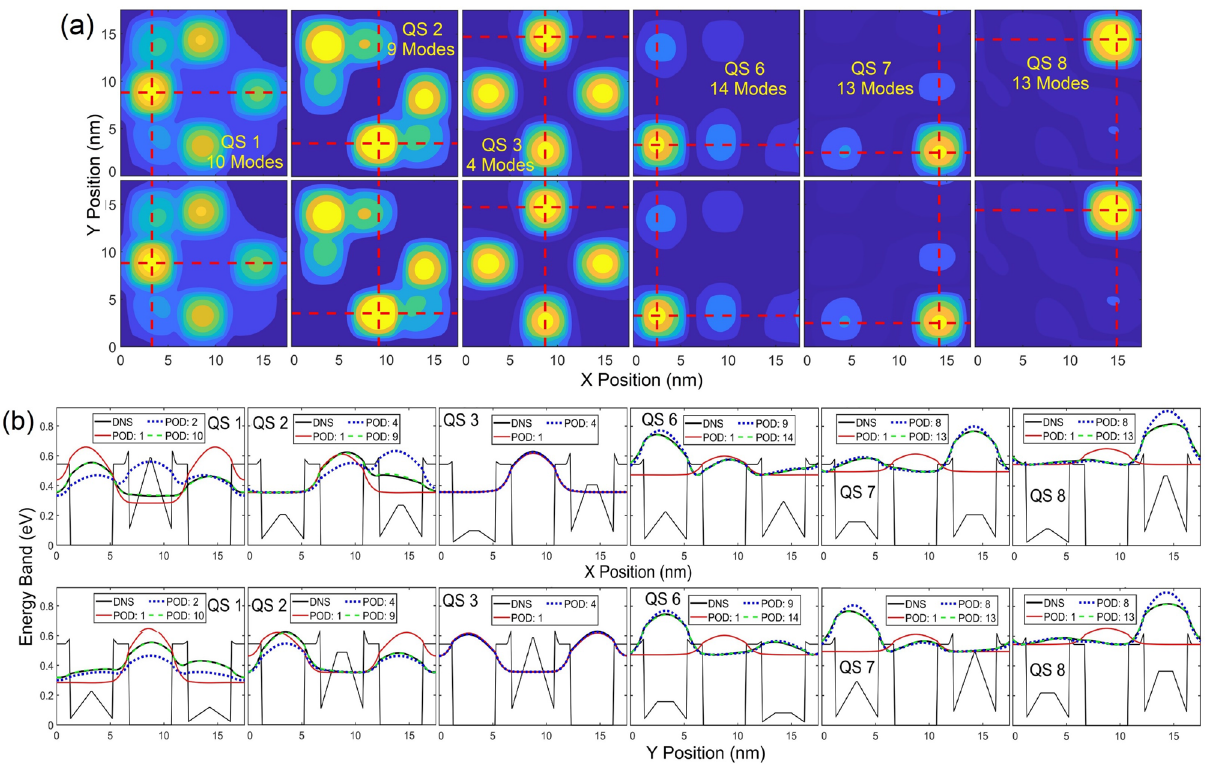
Figure 12. ( a ) Contours and ( b ) cross sectional profiles of | ψ | 2 in QSs 1, 2, 3, 6, 7 and 8. In ( a ), the upper and lower rows show | ψ | 2 obtained from POD-Galerkin and DNS, respectively. The dashed horizontal and vertical lines in ( a ) reference the profiles visualized in ( b ) along x and y in the upper and lower rows,